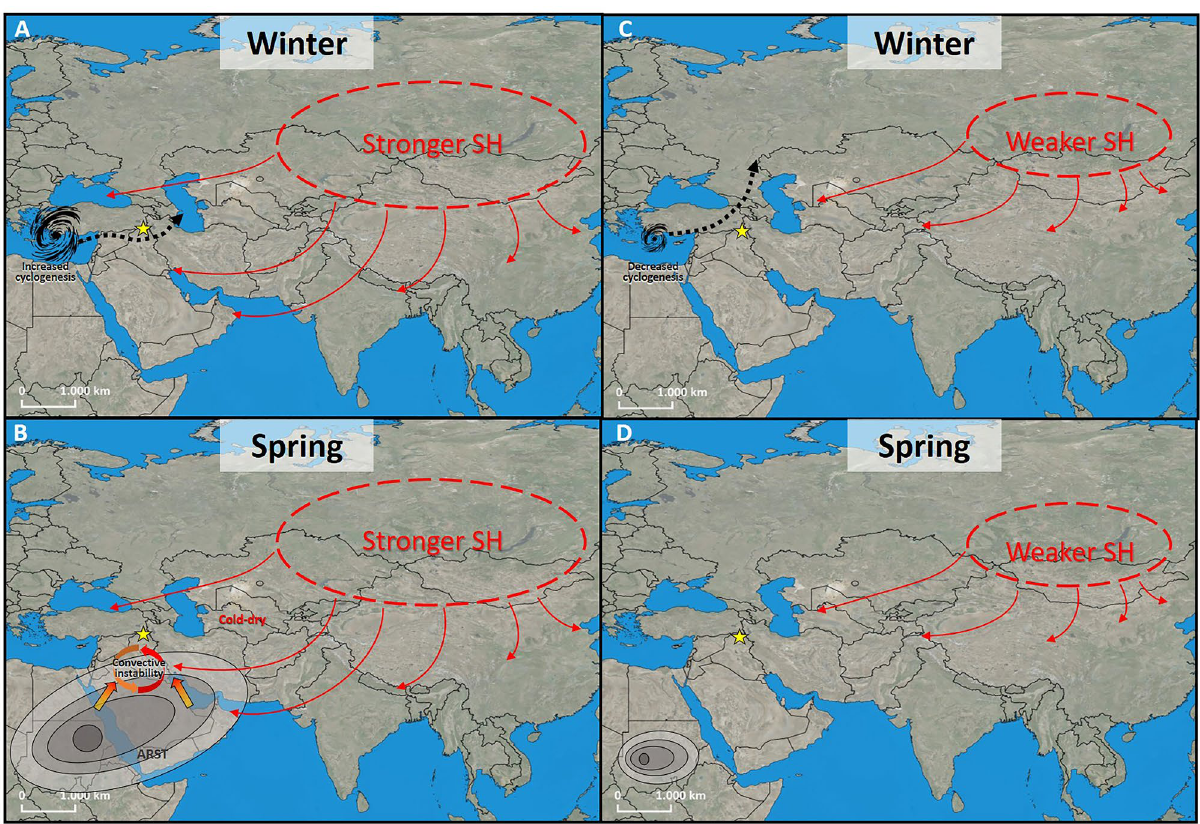
Figure 5. Schematic of the proposed mechanisms influencing precipitation in Northern Iraq. For stronger ( A , B ) and weaker ( C , D ) Siberian High on winter ( A – C ) and spring ( B – D ) conditions. The star is the LoNAP514 cave site. Red arrows represent the influx of cold-dry air from the SH; the black dotted arrows in panels ( A – C) represent the trajectories of the Eastern Mediterranean storm tracks; the thick red-yellow arrows in panel B represent the low-tropospheric southerly influx of warm and moist air. ARST = Active Red Sea Trough (contracted to Sudan Low in panel). See text for explanation. All maps are elaborated with QGIS 3.16.7 plugin https:// nextg is. com/ blog/ quick mapse